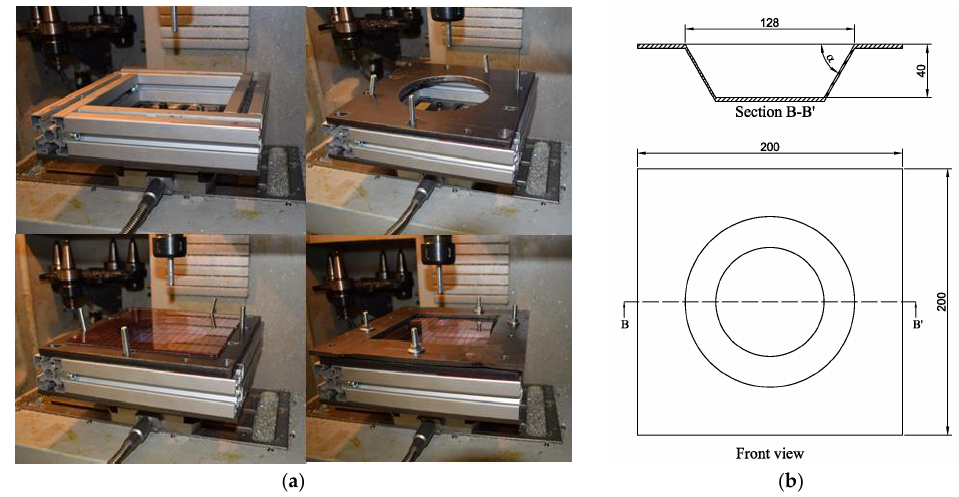
Figure 4. Setup for SPIF: ( a ) CNC machine with fixing system; ( b ) Shape of processed sheet.